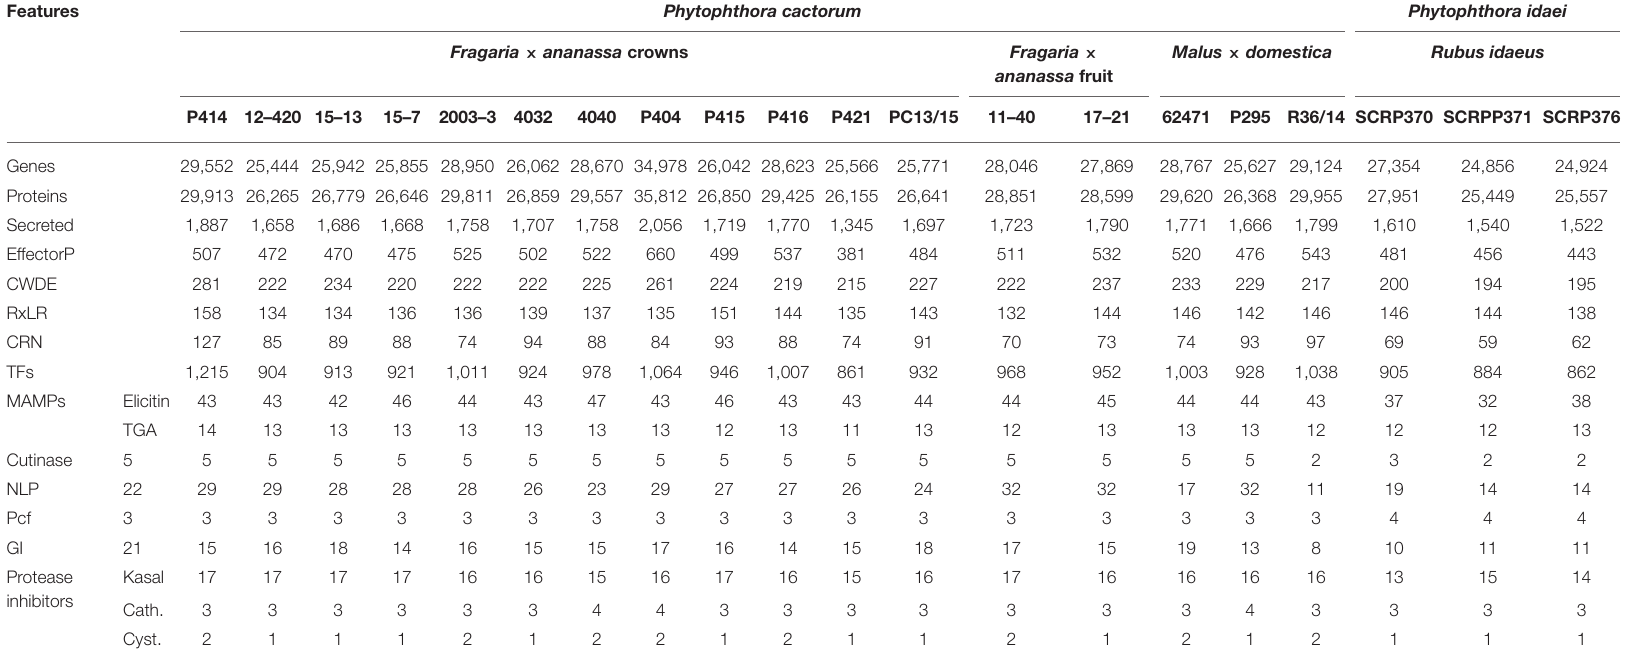
TABLE 3 | Predicted gene models and